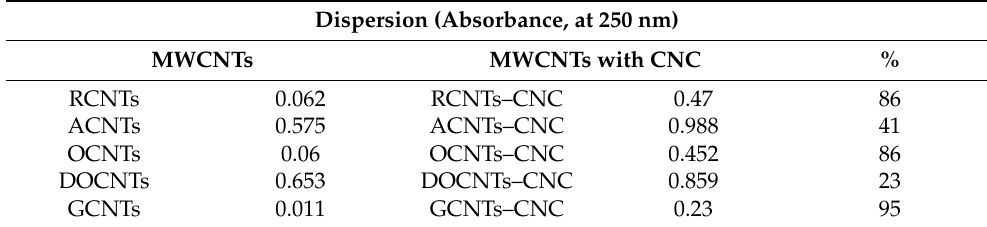
Table 1. Comparison of the improvement (%) in dispersion for the nanofluids from UV–Vis spectra (absorbance, at 250